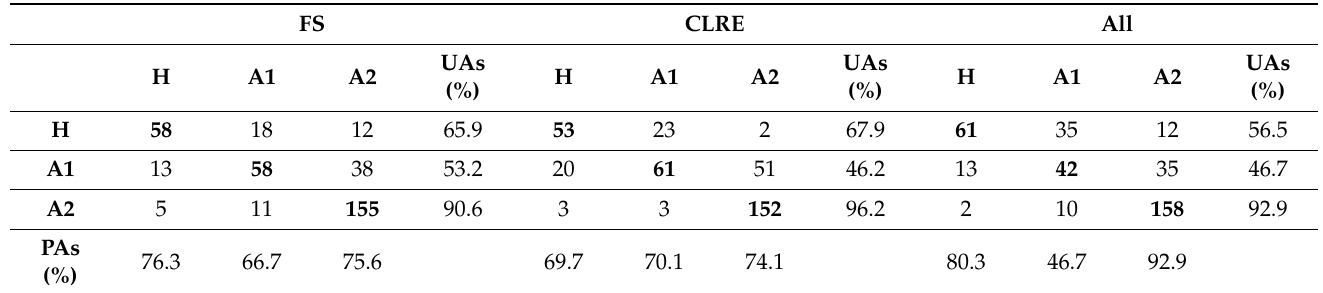
Table 5. Confusion matrices for the best wSVM model using a selection of the indices performed with the feature selection (FS), the one using the best individual index (CLRE), and all the available indices (All) over the 3-fold cross validation. Numbers in bold are the diagonal of the matrix.